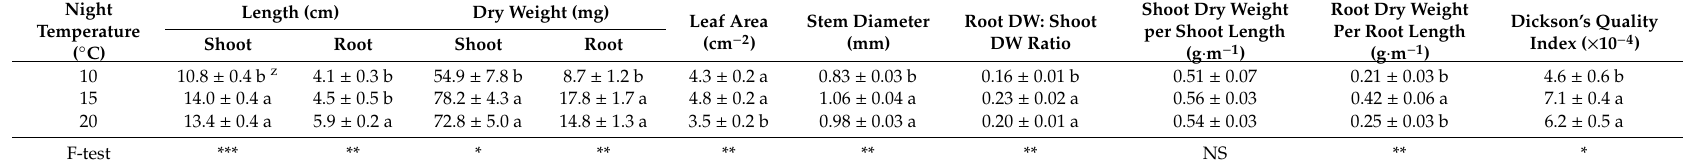
Table 1. E ff ect of night temperature on the growth parameters of A. membranaceus plug seedlings.